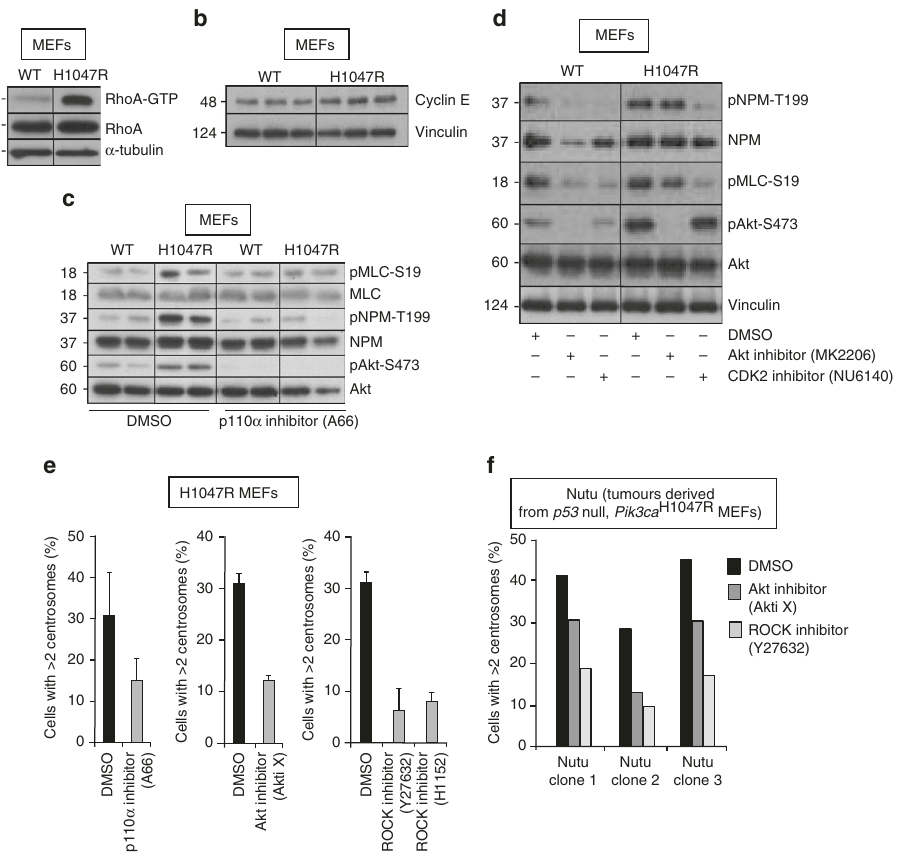
Fig. 4 p110 α H1047R expression leads to centrosome overduplication through RhoA and ROCK pathway activation. a Assessment of RhoA activity in Pik3ca WT ; Flpe-ER T2 and Pik3ca H1047R+neo ; Flpe-ER T2 MEFs, 3 days after treatment with 4-OHT. The experiment was performed three times using three independent Pik3ca WT ; Flpe-ER T2 and Pik3ca H1047R+neo ; Flpe-ER T2 MEFs. A representative experiment is shown. b Cyclin E protein levels in Pik3ca WT ; Flpe- ER T2 and Pik3ca H1047R+neo ; Flpe-ER T2 MEFs, 3 days after treatment with 4-OHT. Cell extracts from three independent MEF lines per genotype are shown. c Activation of signalling pathways involved in centrosome duplication by p110 α H1047R expression, and effect of p110 α inhibition (by 24 h of treatment with 3 µ M A66). Cell extracts from two independent MEF lines per genotype are shown. d Effect of inhibition of CDK2 (by 2 h of treatment with 1 µ M NU6140) or Akt (by 2 h of treatment with MK2206) on signalling pathways involved in centrosome duplication. e Impact of inhibition of p110 α (by 3 µ M A66), Akt (by 1 µ M Akti X) or ROCK (by 10 µ M Y27632 or 0.5 µ M H1152) on p110 α H1047R -induced centrosome ampli fi cation in primary MEFs. A total of 100 cells